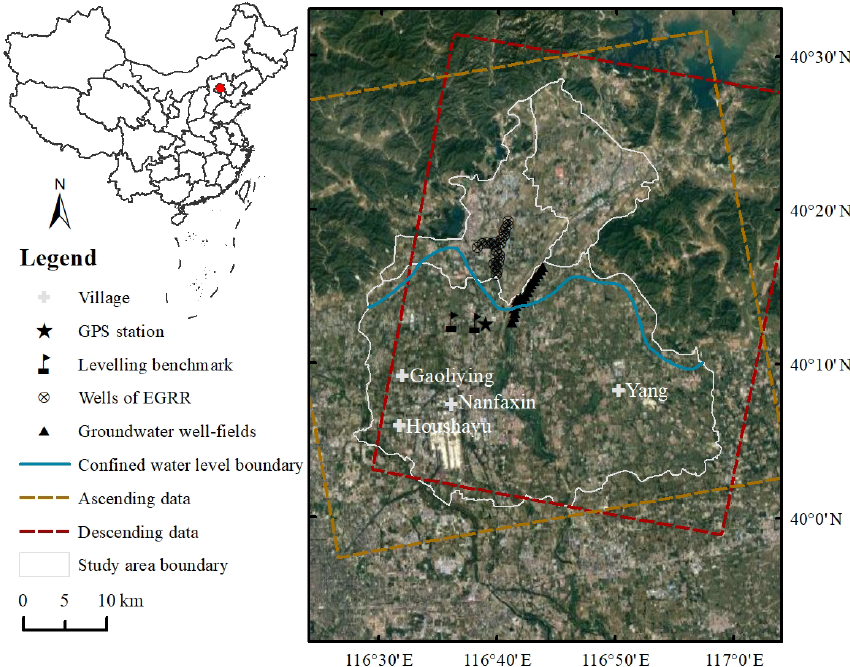
Figure 1. Location of the study area. Background image of the optical remotely sensed image from © Google